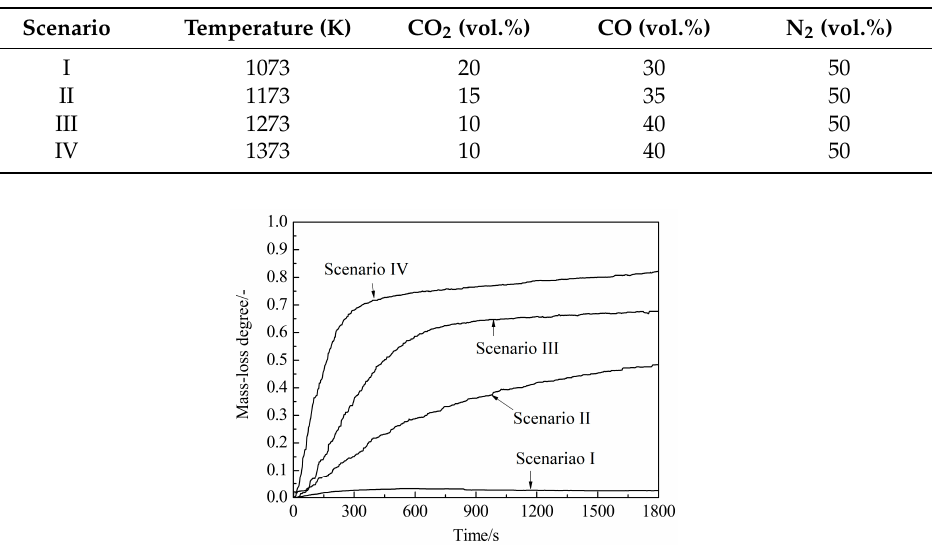
Figure 6. Variation of mass-loss degree with time under different scenarios.